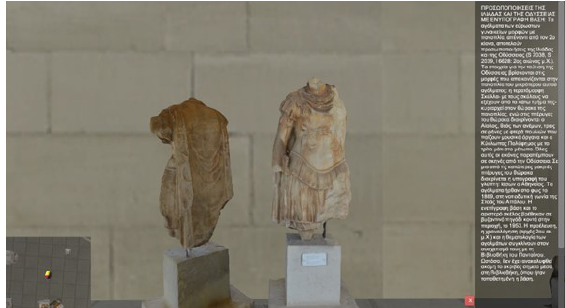
Figure 8: A snapshot from the virtual museum. The visitor chose to rotate the left sculpture, while the available information appears on the right of the screen. The mini-map